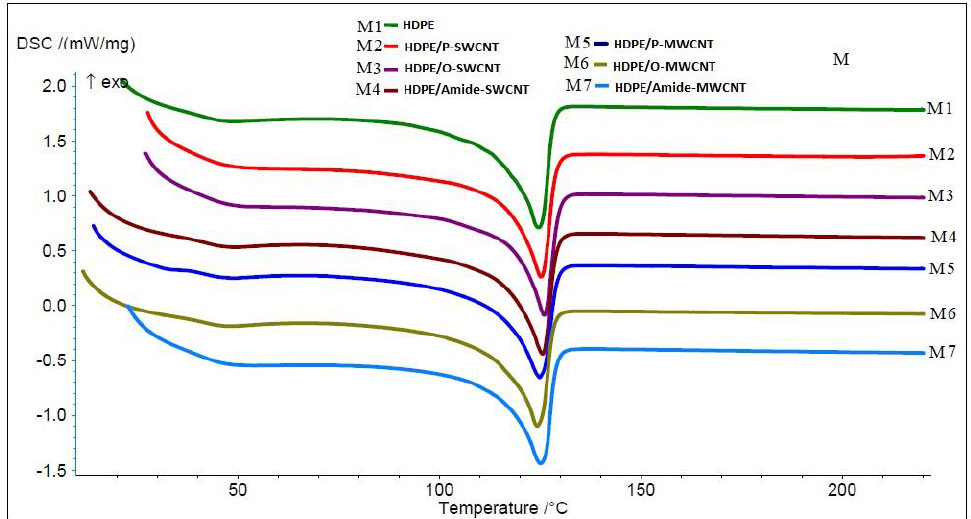
Figure 5. The DSC heating thermograms for the nanocomposite sheets M1 – M7 measured with heating rate of 10 °C/ min from 25 °C to 220 °C, under nitrogen atmosphere.